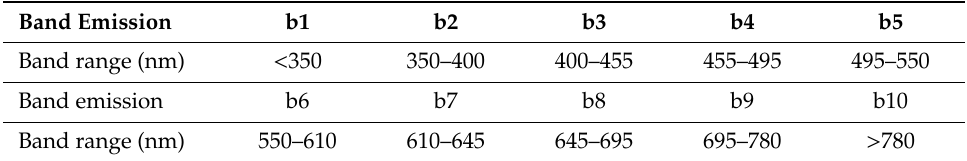
Table 1. The band emission labels (b1–b10) and the range of their transmission (in nm) for all filters used in the spectral